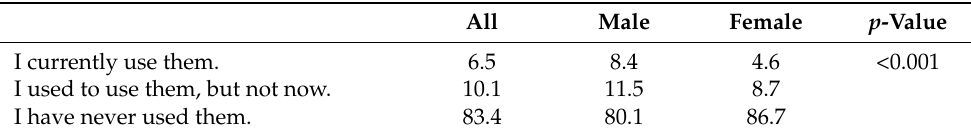
Table 12. Utilization of application programs for nutrition analysis in foods. All Male Female p